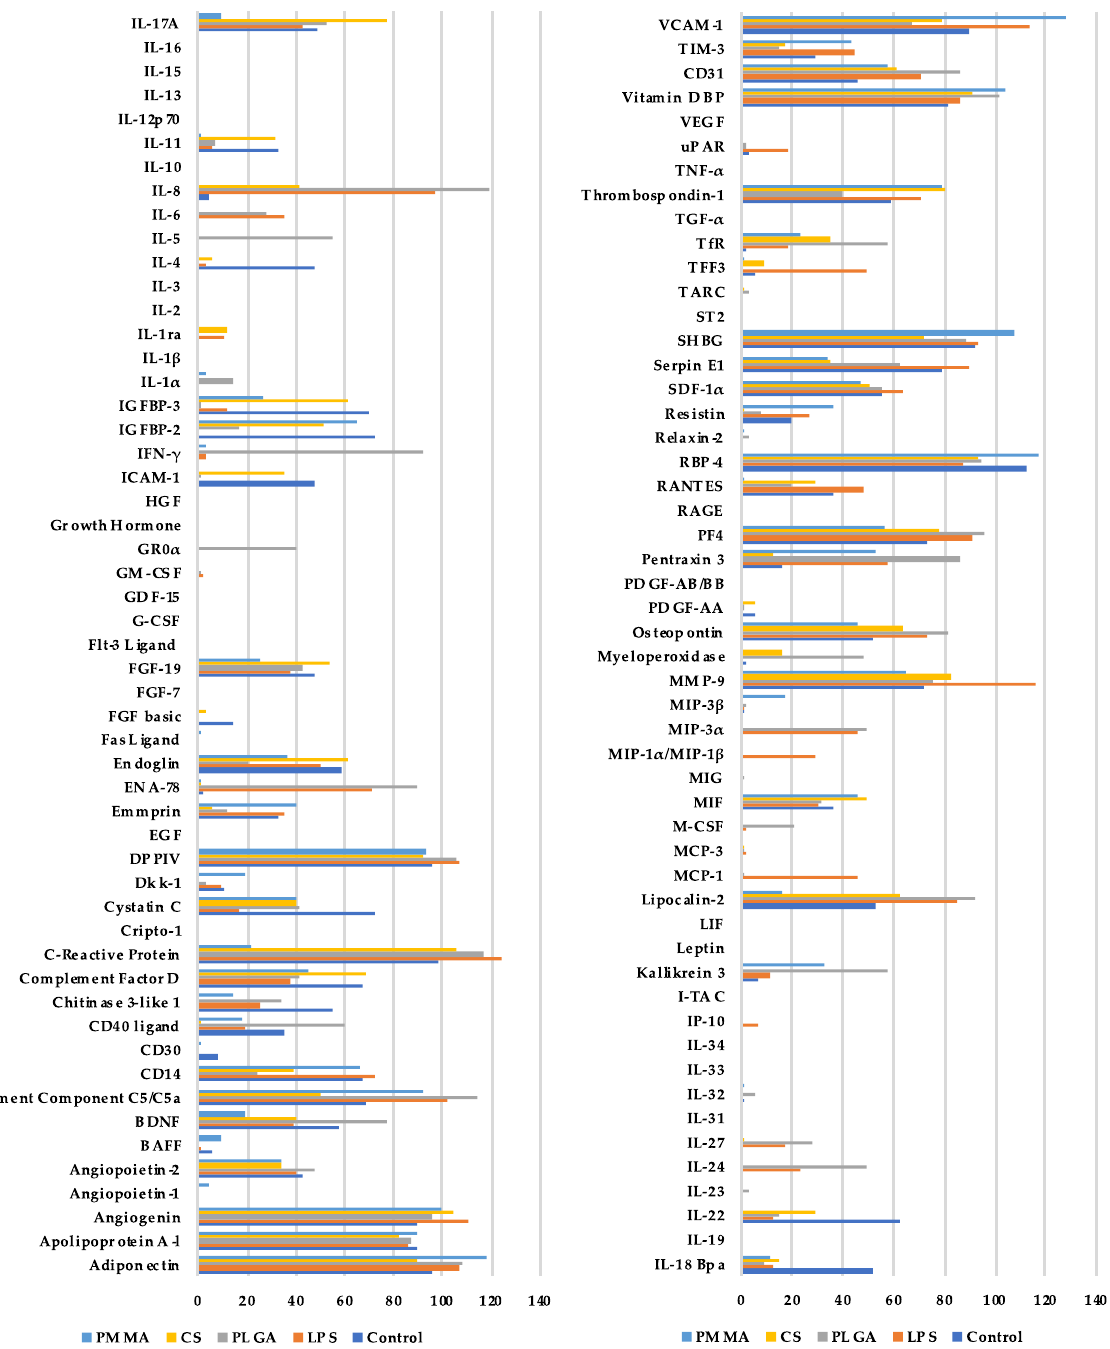
Figure 3. Overview of all the parameters measured. Median values of the three probands are presented. Ctrl (control), PLGA (poly(lactic-co-glycolic acid), CS (calcium sulphate scaffold), PMMA (polymethylmethacrylate).